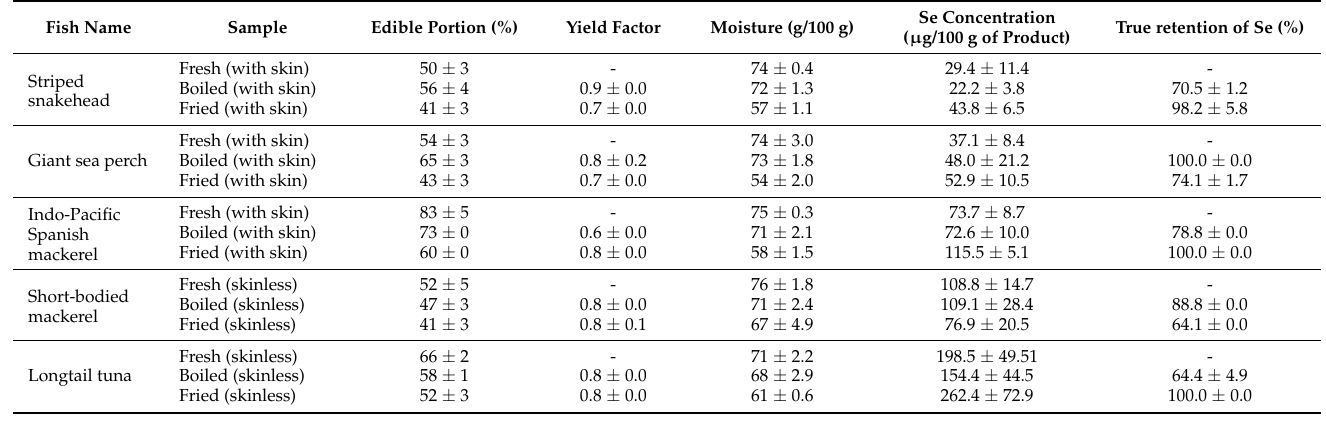
Table 3. Data on percentage of edible portion, yield factor, and moisture content of 3 individual samples (expressed as mean ± SD) from each type of selected fish.